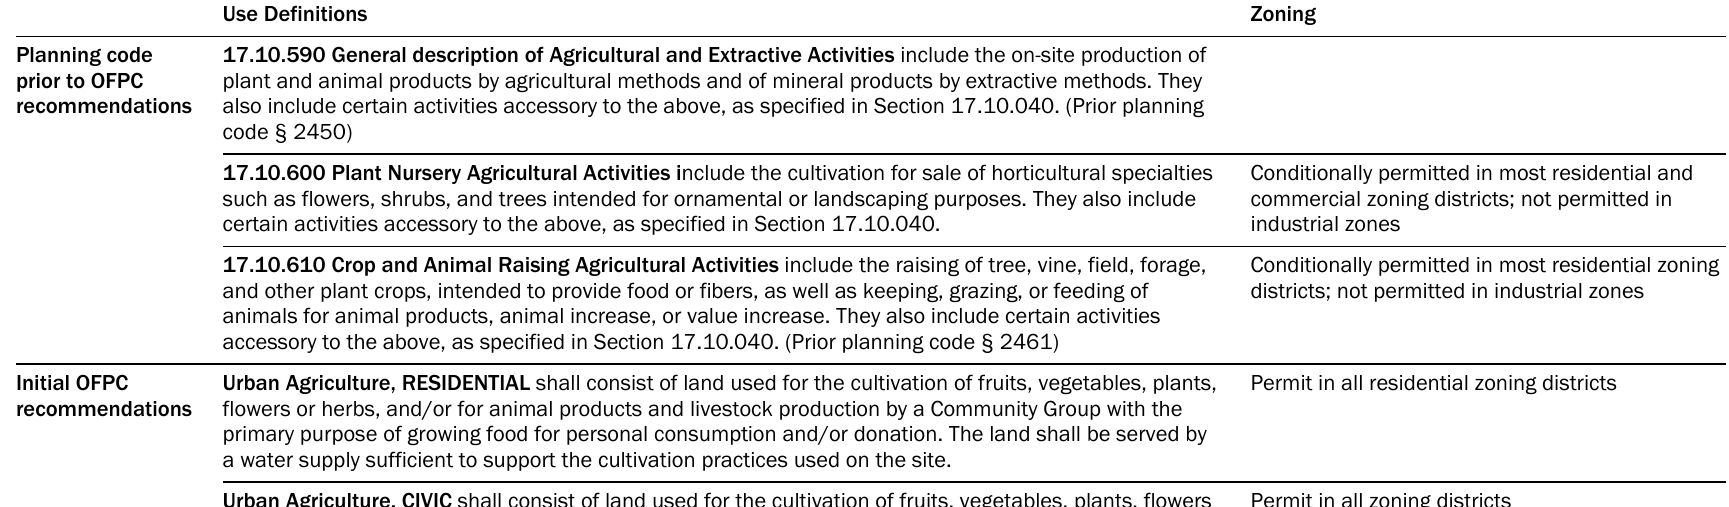
Table 2. Original, Proposed, and Interim Use Definitions and Zoning Related to Urban Agriculture in Oakland, California Use